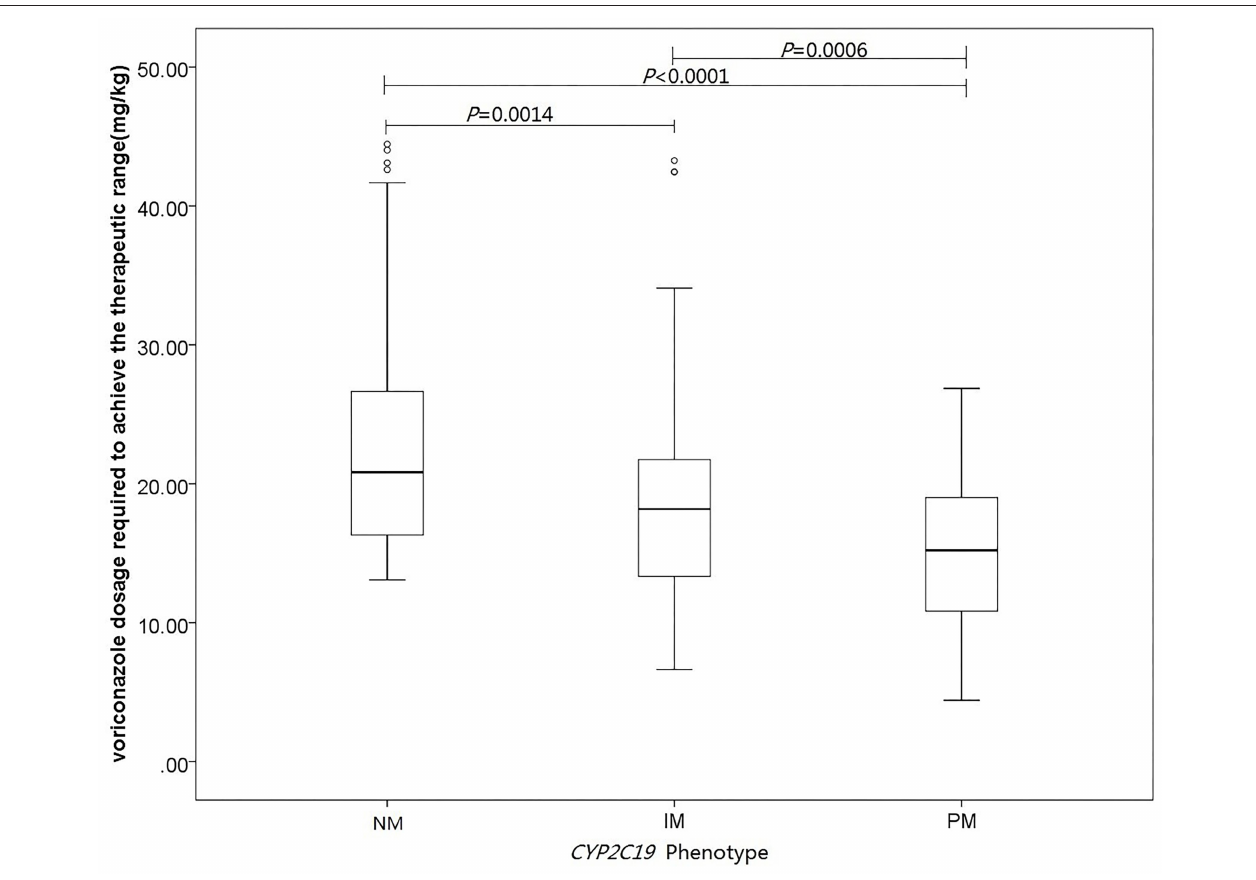
FIGURE 2 | Influence of CYP2C19 genotype and other covariates on voriconazole dose requirements. Linear mixed-effects regression analysis of the relationship between CYP2C19 phenotypes and voriconazole dose required to achieve the therapeutic range (mg/kg).